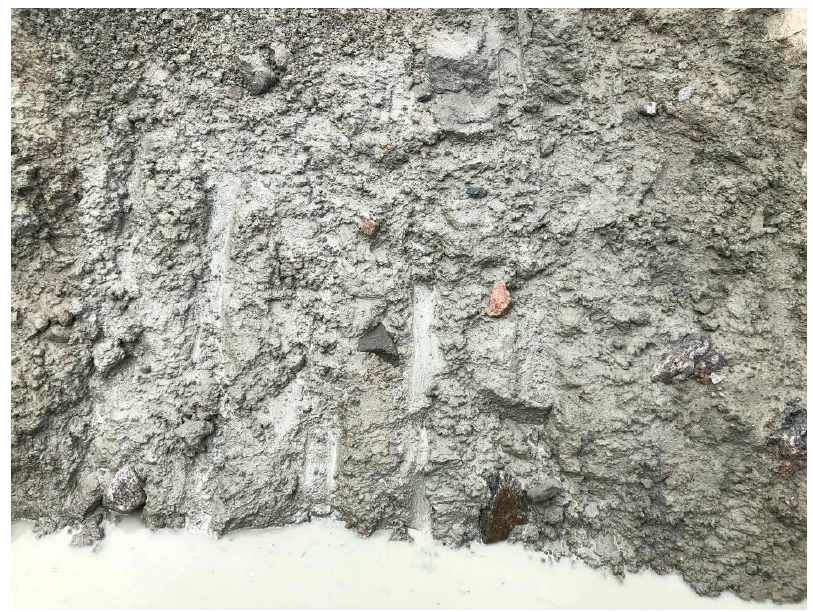
Figure 9. Pressure-washed face of the excavation’s west side, adjacent to the grouping of shards at the 4.7 ± 0.1 m depth found in the 2018 excavation. the 4.7 ± 0.1 m depth found in the 2018